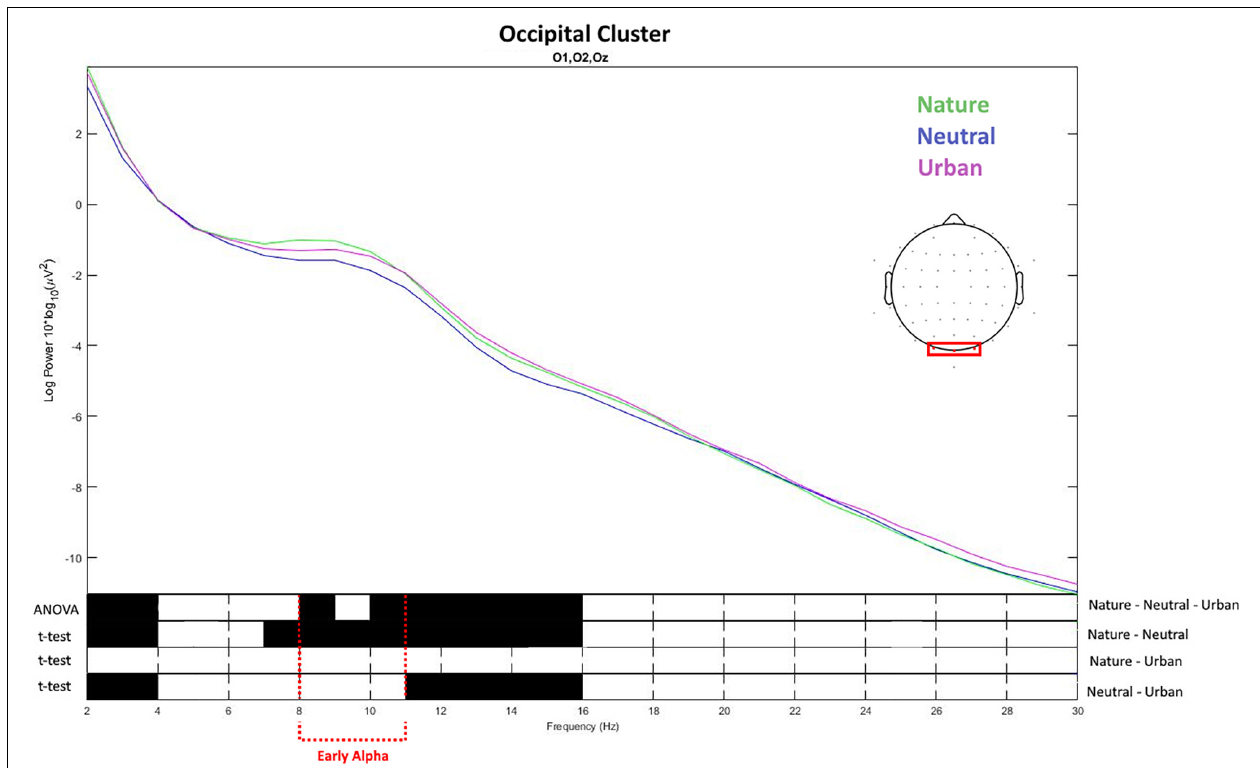
FIGURE 7 | The top of the figure presents the values of spectral power obtained averaging the values for the electrodes placed over the occipital brain area. The frequency ( X -axis) and spectral power ( Y -axis) for the three experimental conditions (neutral, nature, and urban videos). The bottom of the figure shows the results of ANOVA and t -tests for the difference between the conditions on the spectral power for each frequency from 2 to 30 Hz. Black color shows the frequency values in which the spectral power values were statistically different between the conditions.